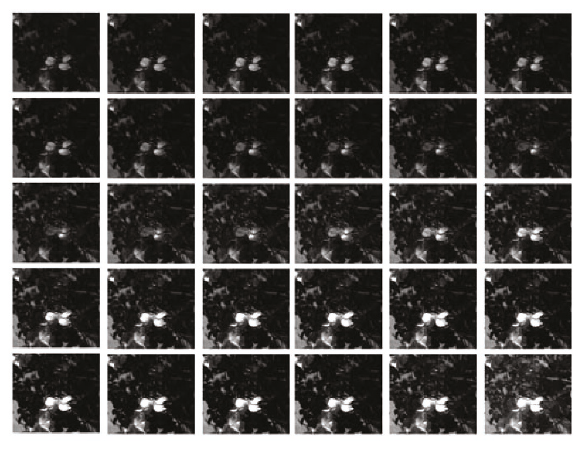
Figure 2: Illustration of images corresponding to di ff erent bands of the hyperspectral